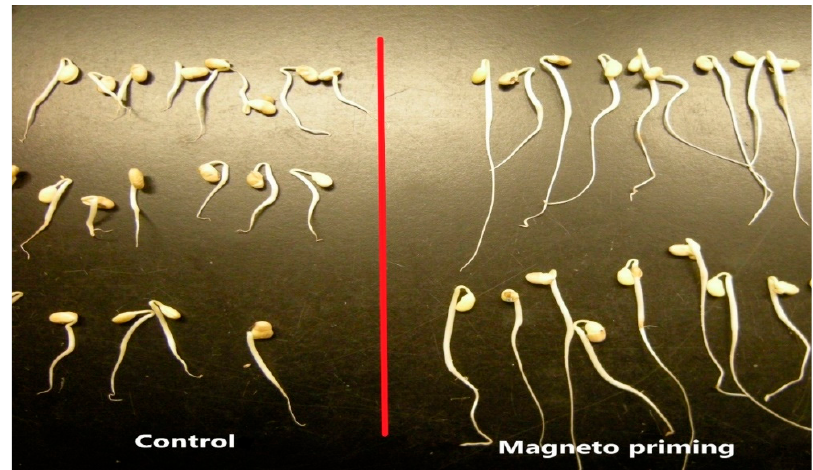
Figure 4. Seedlings originating from the germination pattern test for cultivar C02 before and after the magneto-priming.